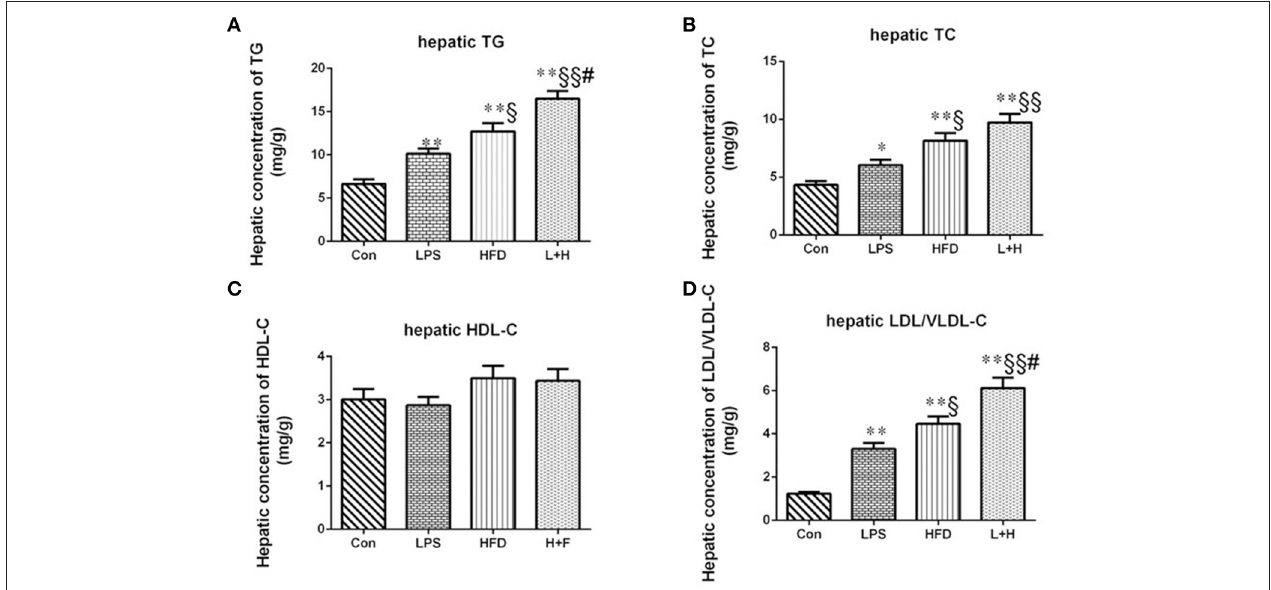
FIGURE 3 | Hepatic contents of triglycerides (A) , total cholesterol (B) , high-density lipoprotein cholesterol (C) , low/very low-density lipoprotein cholesterol (D) in 8-week-old offspring rats. The data are presented as the mean ± SEM. n = 6 in each group. * P < 0.05, ** P < 0.01 vs. control, § P < 0.05, §§ P < 0.01 vs. LPS group, # P < 0.05 vs. HFD group (One-way ANOVA). Con group, male offspring rats treated with prenatal saline and postnatal normal diet from 4 to 8 weeks old; LPS group, male offspring rats treated with prenatal LPS and postnatal normal diet from 4 to 8 weeks old; HFD group, male offspring rats treated with prenatal saline and postnatal high fat diet from 4 to 8 weeks old; L + P group, male offspring rats treated with prenatal LPS and postnatal high fat diet from 4 to 8 weeks